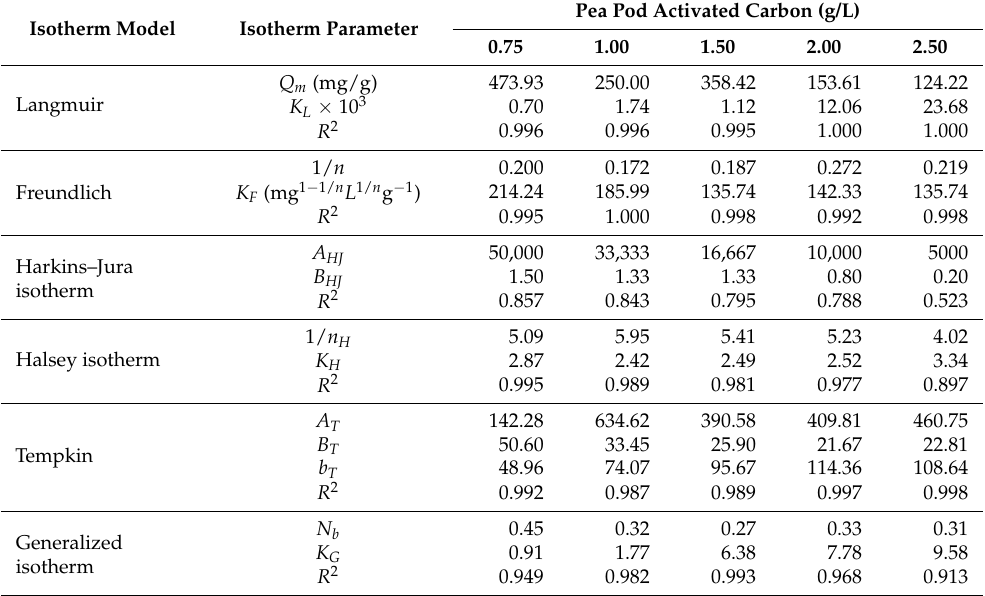
Table 2. Isotherm study results of AO7 dye adsorption at room temperature (25 ± 2 ◦ C) onto activated carbon generated at 800 ◦ C carbonization temperature under CO 2 using ZnCl 2 as the activating agent (AC-ZnCl 2 ) at varying initial concentrations (100–400